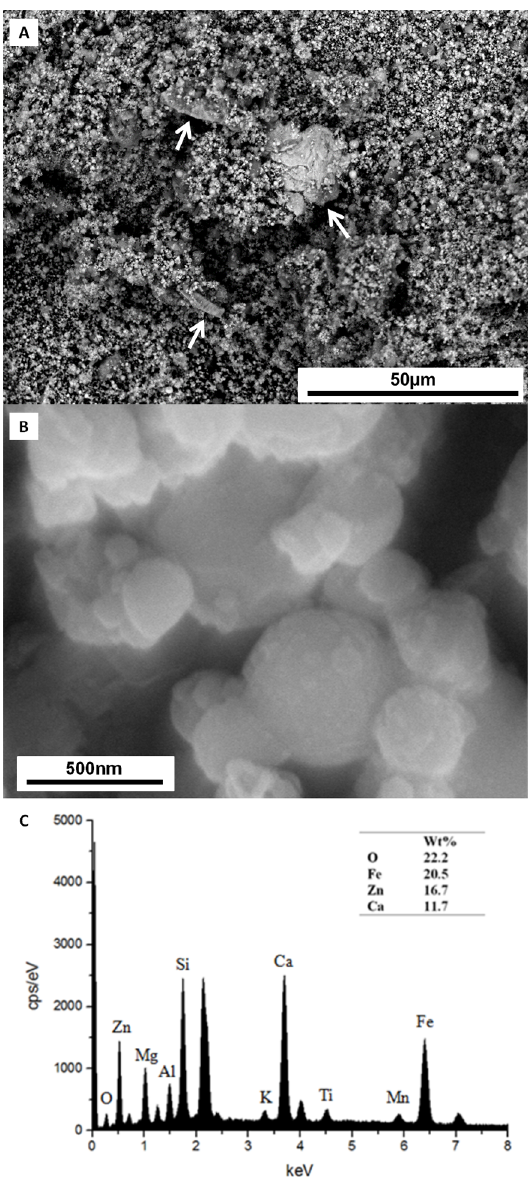
Figure 4. SEM images of Al-5%EAFD sintered composite with magnification of 200x (A); irregular particles of EAFD with magnification of 500x (B) and single agglomerated particle in metal matrix